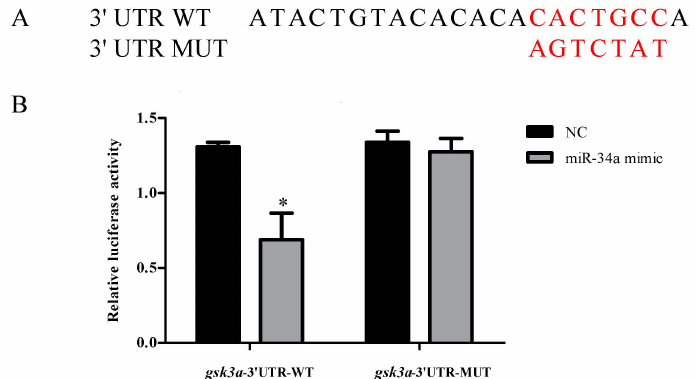
Figure 7. miR-34a directly targets gsk3a . ( A ) The sequence information of the putative gsk3a 3 (cid:48) UTR binding site in wild type (UTR WT) and mutant (UTR MUT); ( B ) Luciferase assays of miR-34a co-transfection with UTR WT plasmid and UTR MUT plasmid in HEK293T cells. The luciferase activity of WT plasmid was reduced by miR-34a. NC stands for negative control mimic. Error bars indicate mean ± SD, n = 3. Student’s t -test was used for statistical analysis (* p <